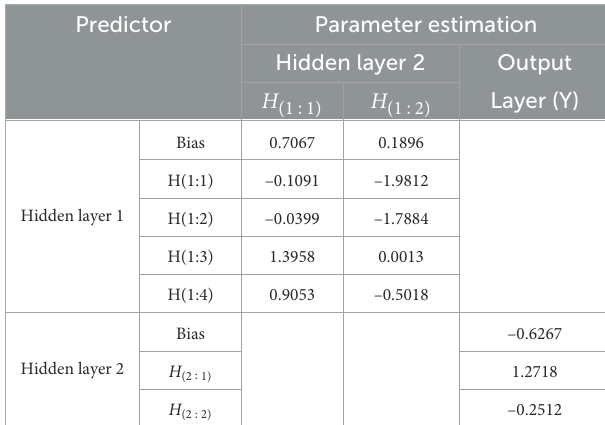
TABLE 9 Parameter estimation of FFNN model from hidden layer to output layer.